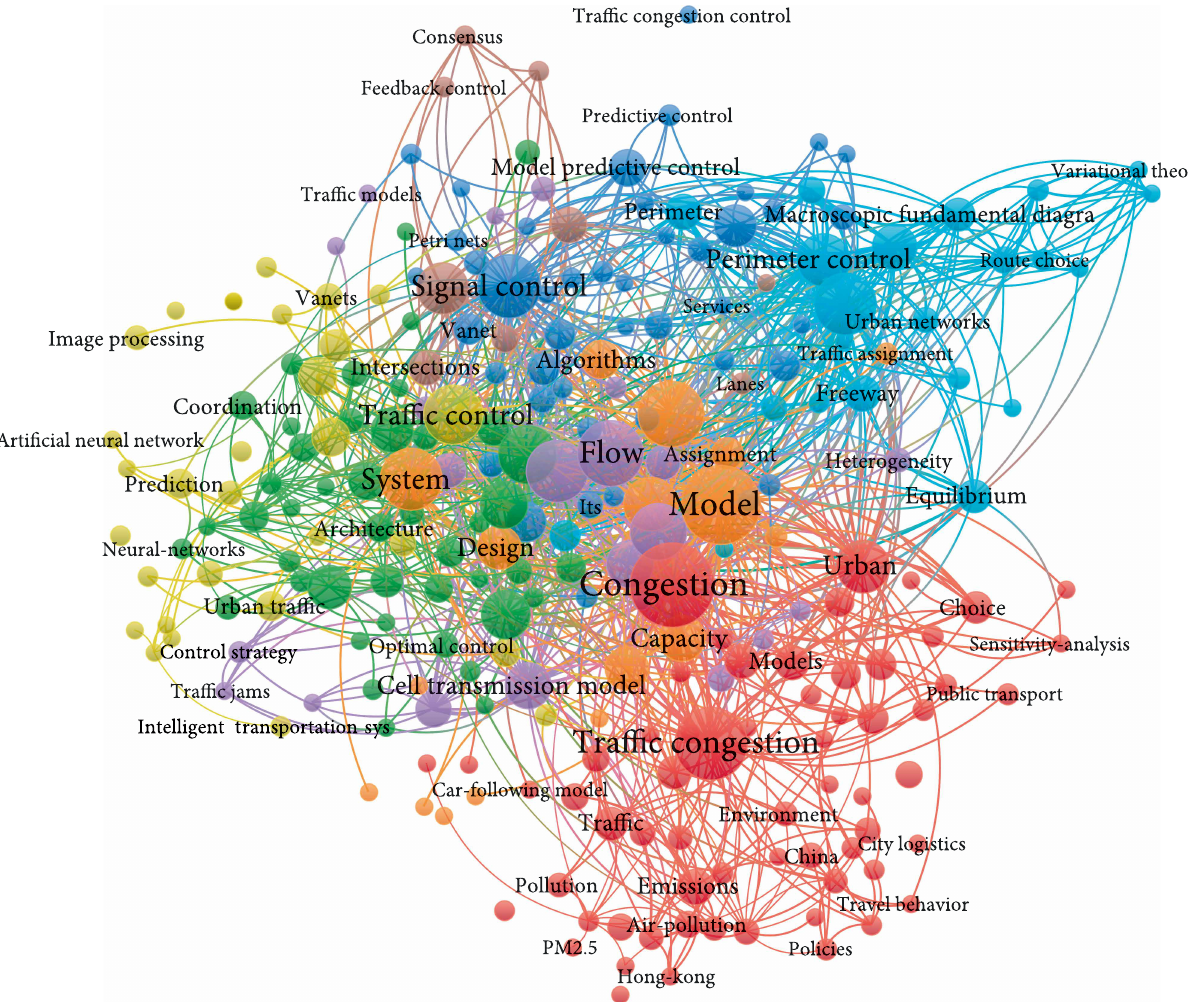
Figure 1: Keyword co-occurrence network of traffic congestion